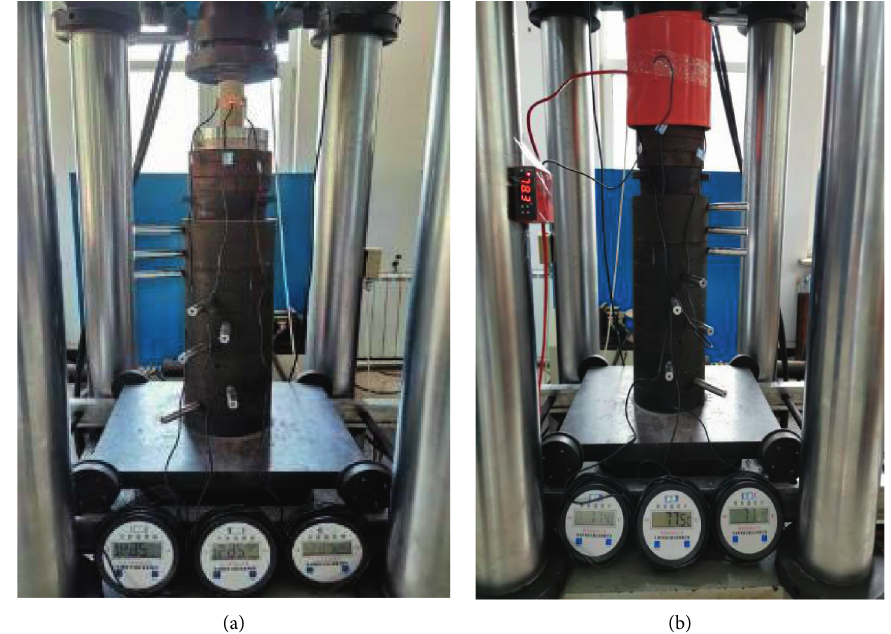
Figure 12: Uniaxial compression test of similar materials at different temperatures covered by the study.